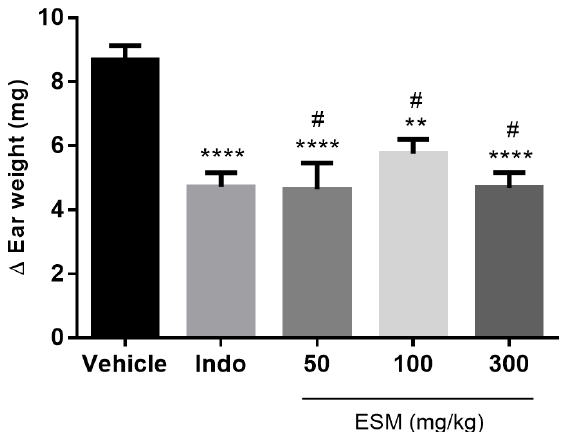
Figure 6. Effect of different doses of ESM on the number of writhings in acetic acid-induced in mice. The vehicle, indomethacin 10 mg/kg, and ESM 50, 100, and 300 mg/kg were administered orally 60 min before acetic acid 0.6% injection. The number of writhings was counted for 30 min. The values of each column represent the mean±S.E.M. ANOVA followed by the Tukey test, used as post hoc . Significant values:** p < 0.01 and **** p < 0.0001 compared to the vehicle group; # means statistically equal to the reference drug (indomethacin).